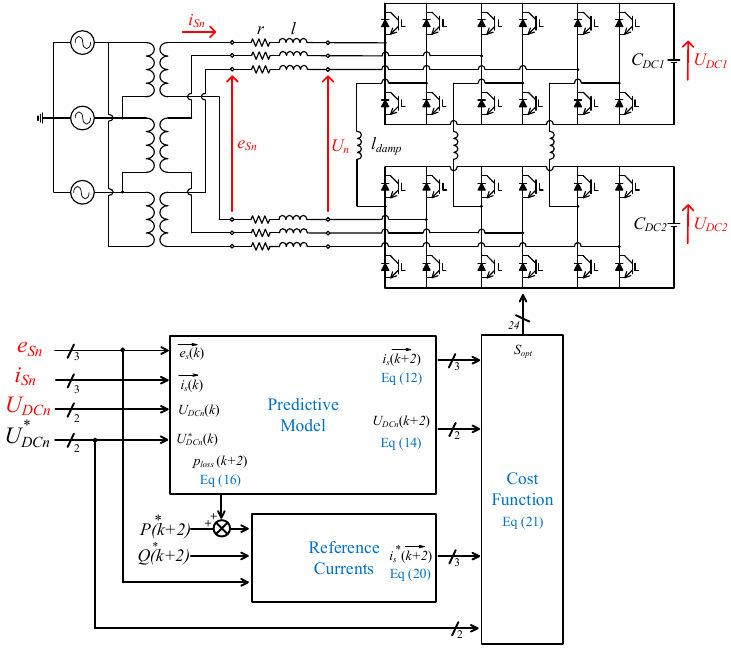
Figure 6. Graphical description of CHB-SDC synchronous static compensators (STATCOM) topology using model predictive control (MPC).